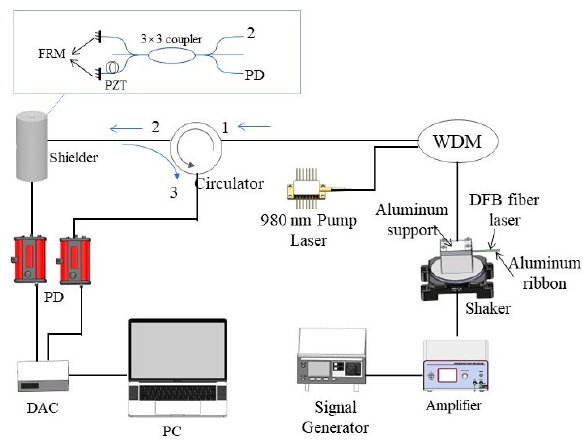
Figure 7. The experimental setup for acceleration sensitivity of the sensor.